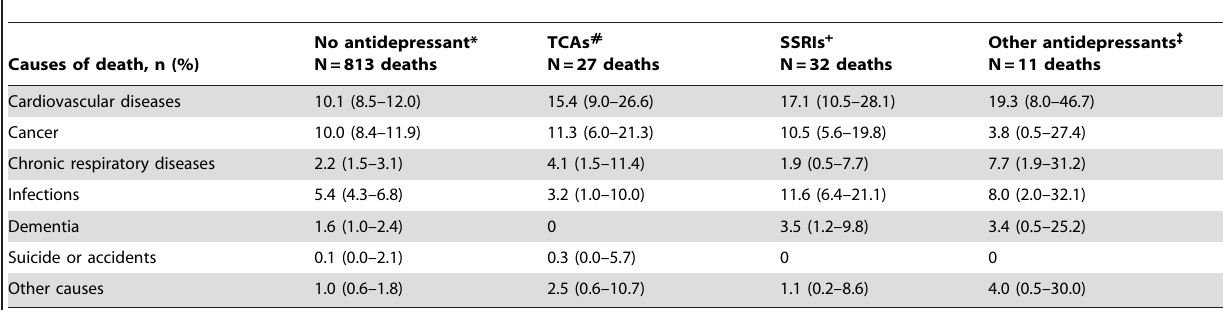
Causes of death, n